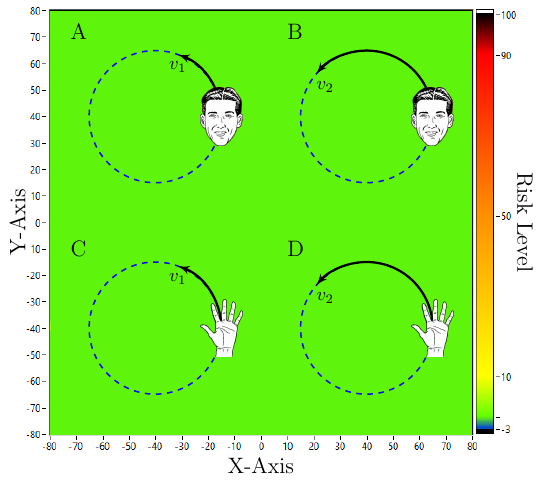
Figure 6: Simulation